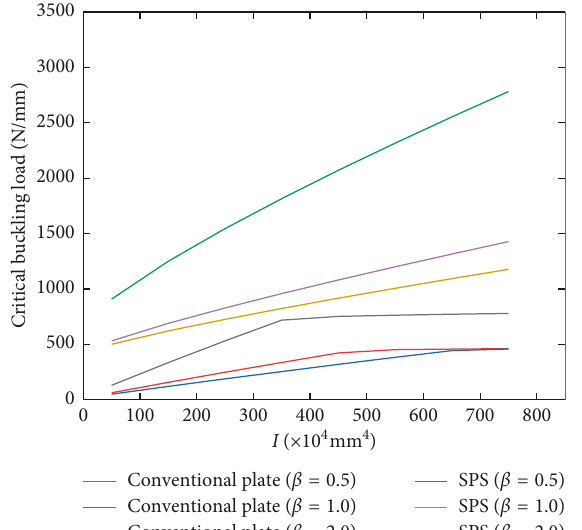
Figure 14: Critical buckling loads in ribbed SPSs and conventional plates with different inertia moments of stiffeners.